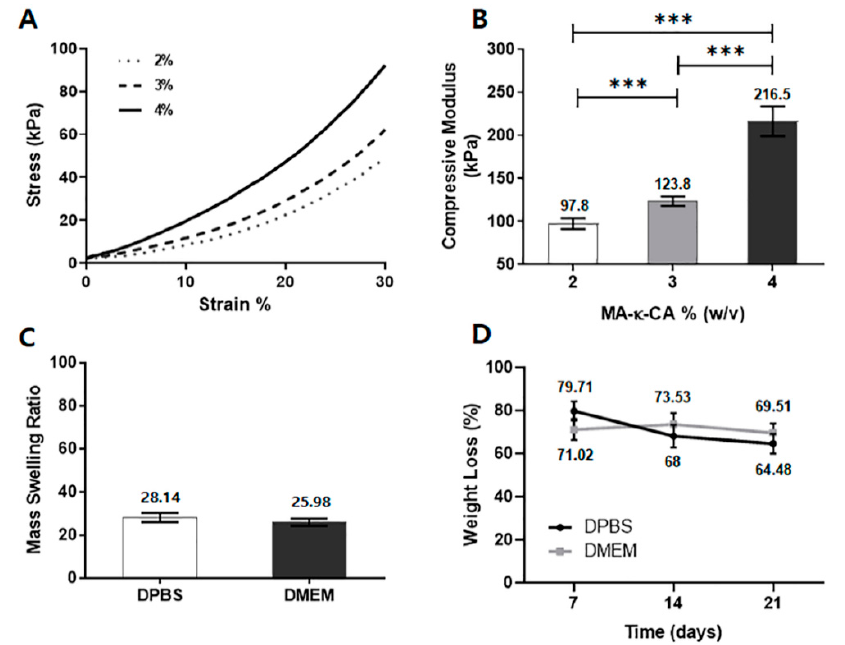
Figure 5. Mechanical properties, mass swelling ratio and degradation behavior of MA- κ -CA hydrogel. ( A ) Representative curves of 2%, 3% and 4% MA- κ -CA at 12% degree of methacrylation. ( B ) Young’s modulus of 2%, 3% and 4% (w / v) MA- κ -CA at 12% degree of methacrylation. ( C ) The mass swelling ratio of 3% (w / v) MA- κ -CA hydrogels in DPBS and DMEM. ( D ) Representation of weight loss percentage according to time of 3% MA- κ -CA hydrogels, immersed in DPBS and DMEM at 37 ◦ C. ( n = 3) ± standard deviation (*** p < 0.001).